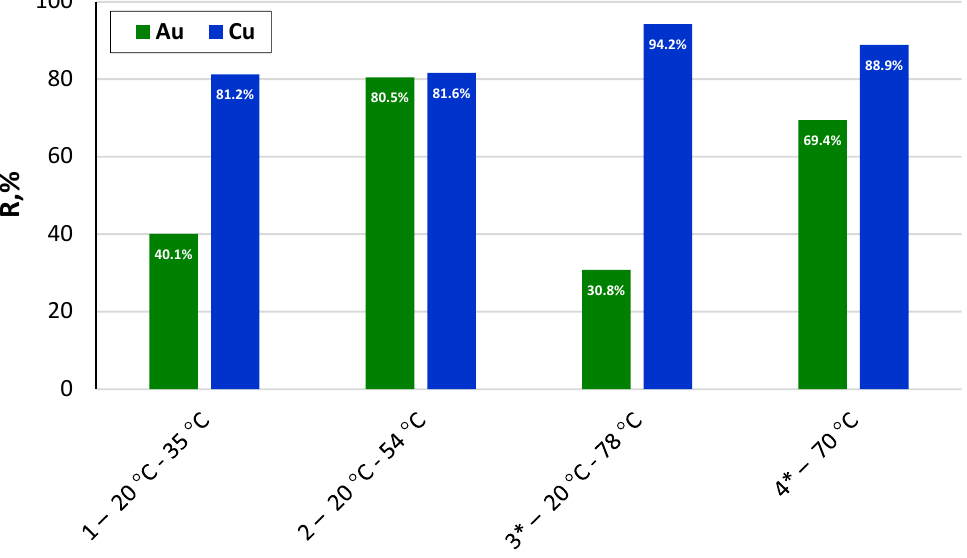
Figure 12. Effect of the electrolyte temperature on the degree of gold and copper leaching from the raw material fraction [A]: 1—Forced electrolyte air cooling; 2—without cooling; 3*—without thermostatic; and 4*—thermostatic at 70 °C. Experimental conditions: 1, 2, 3* and 4*—C HCl = 6 M, 1, 2—I = 0.66 A·cm –2 , t ex = 2 h, S/L = 8.6 g·L –1 ; 3*, 4*—i = 0.64 A·cm –2 , t ex = 2 h, and S/L = 2.9 g·L –1 . * Water-jacketed electrochemical cell.